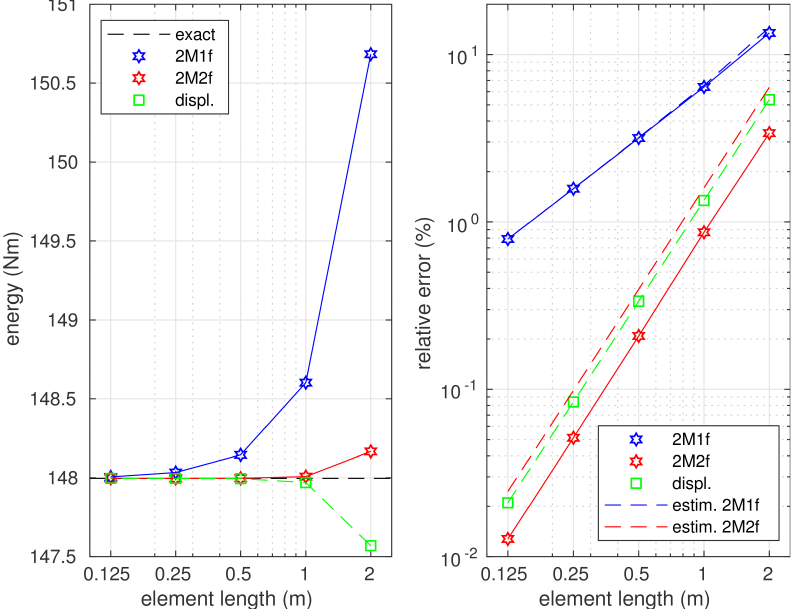
Figure 10. The lower and upper bounds for the strain energy ( left diagram ) and the errors of the approximate solutions ( right diagram